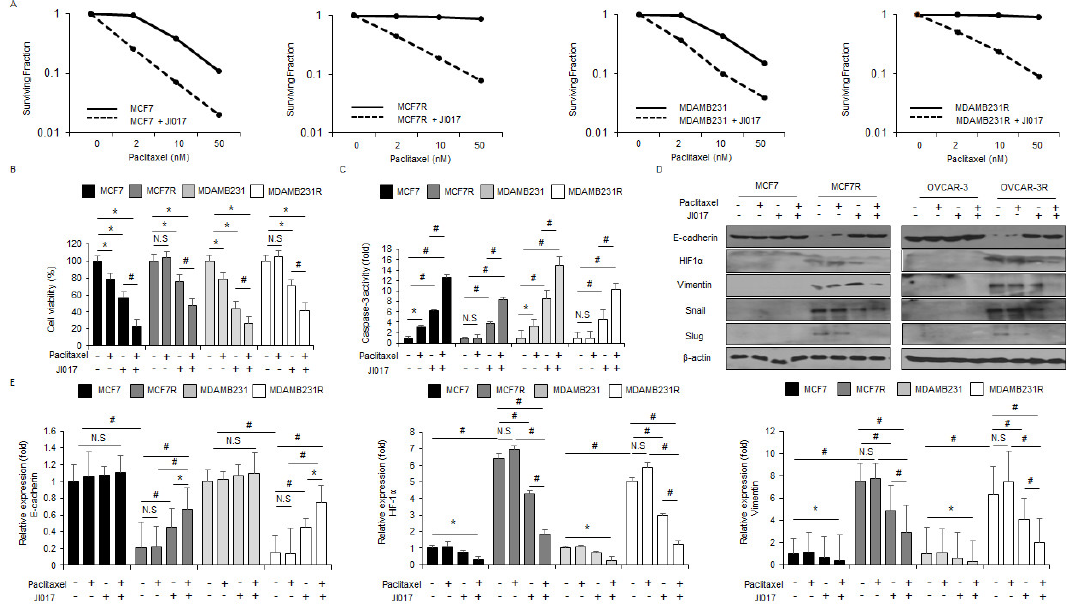
Figure 6. Combined with paclitaxel and JI017 overcome paclitaxel resistance in paclitaxel resistant breast cancer cells. ( A ) A colony formation assay was performed at indicated doses (2, 10, or 50 nM) of paclitaxel and then the survival fraction was calculated using the surviving fraction formula in MCF-7, MCF-7R, MDA-MB-231, and MDA-MB-231R; *, p < 0.05, #, p < 0.01. ( B – E ) MCF-7, MCF-7R, MDA-MB-231, and MDA-MB-231R cells were treated with JI017 (300 µg/mL, 24 h) after exposure to 2 nM paclitaxel. WST-1 assay and caspase-3 activity assay were performed along with a Western blot analysis for E-cadherin, HIF-1α, vimentin, Slug, and Snail and Real-time RT-PCR for E-cadherin, HIF-1α, and vimentin; *, p < 0.05, #, p < 0.01. β-actin was used as the RNA and protein loading control. β-actin was used as the protein loading control.